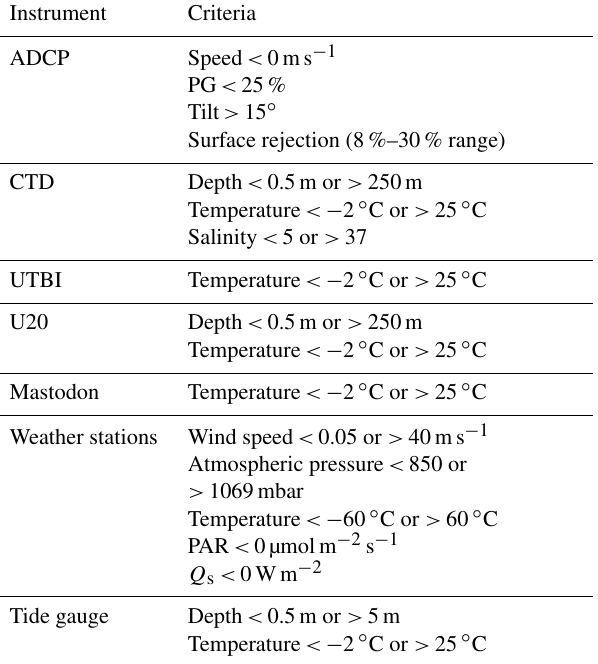
Table 2. “Out-of-range” filters used to quality control the data.